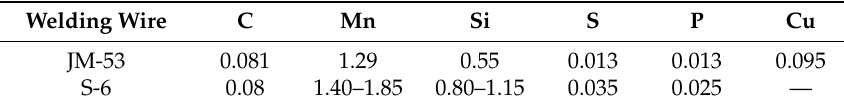
Table 3. Chemical Constituents of weld wire JM-53 and S-6 (%). Welding